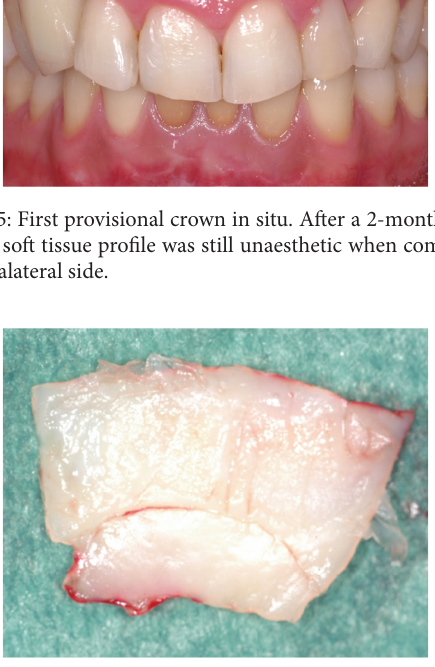
Figure 16: Detail of the epithelialized (lower part) and subepithelial (upper part) connective tissue graft.